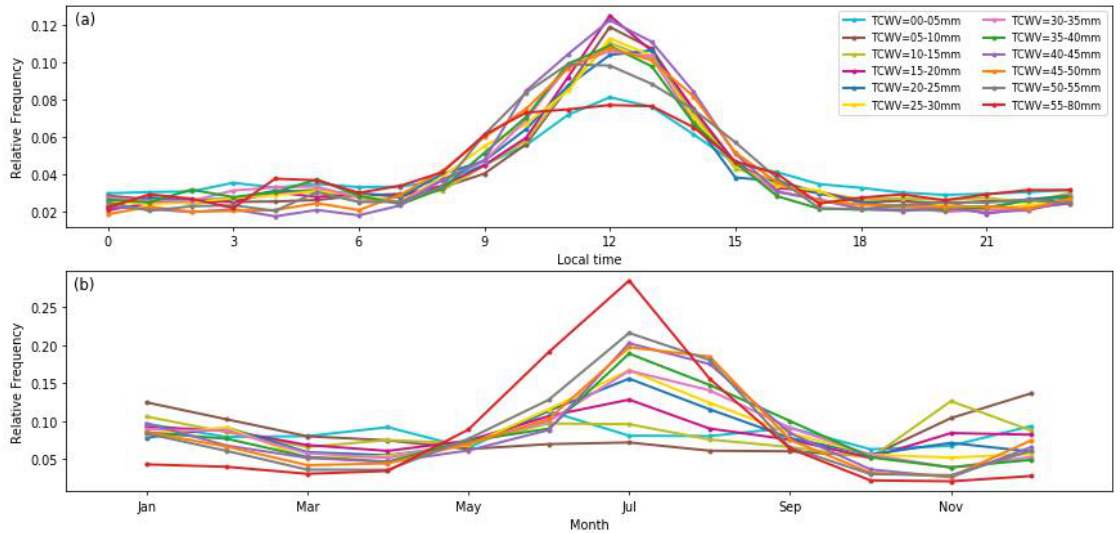
Figure 3. Histograms of local time ( a ) and of the month ( b ) of the selected data for the calibration database for each TCWV class.